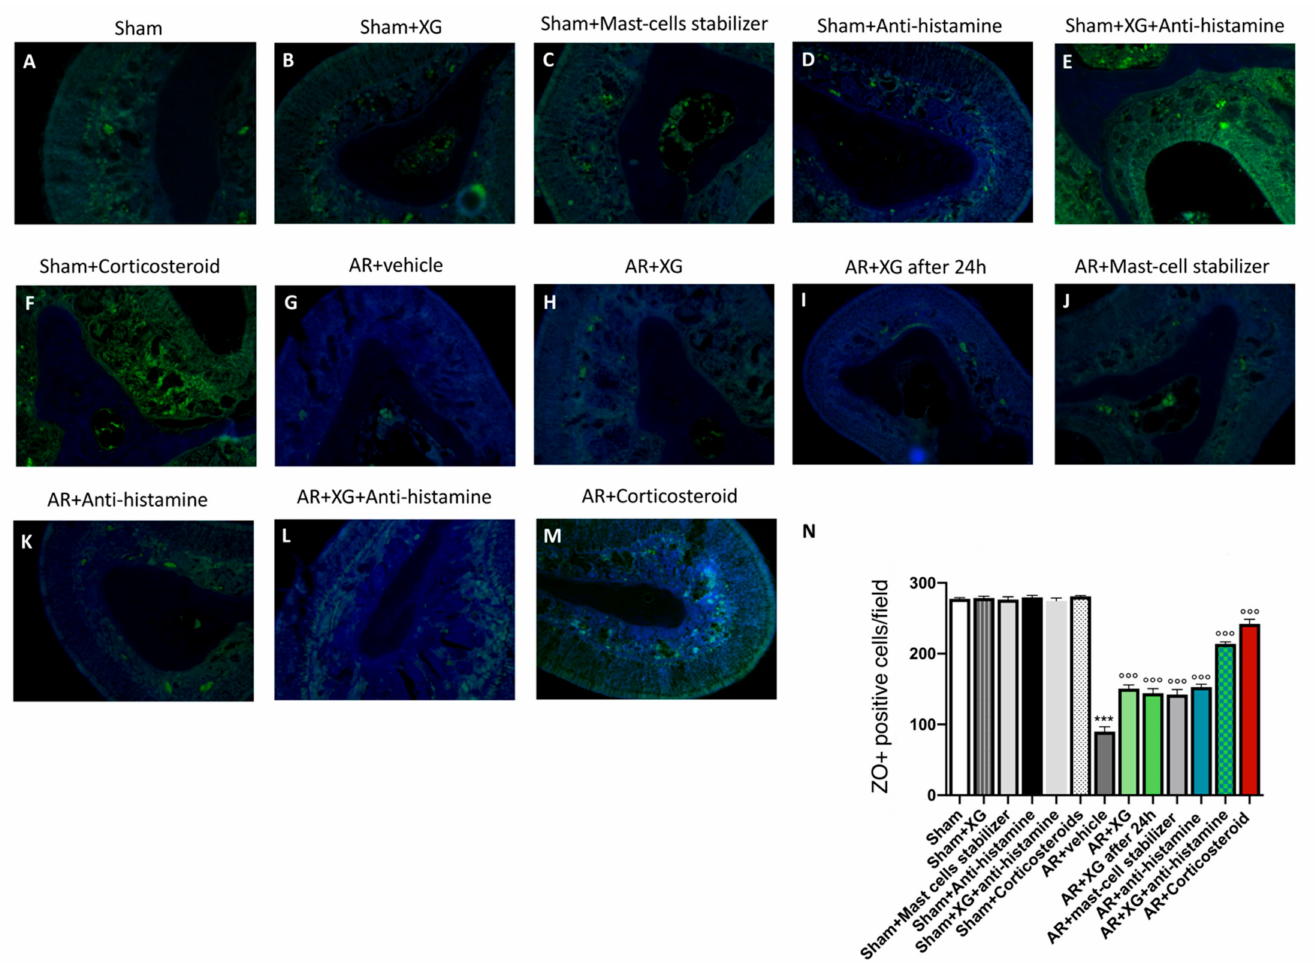
Figure 10. Effect of XG treatment on ZO-1 expression. OVA-challenged nasal mucosa exposed a evident decrease of ZO-1 expression ( G , histological score N ) compared to the sham animals ( A – F , histological score N ); XG-based spray treatment meaningfully preserved ZO-1 expression ( H , I , histological score N ) as well antihistamine ( K , histological score N ) and mast cell stabilizer ( J , histological score N ) treatments. A quantitatively more substantial effect was obtained from the co-administration of XG and antihistamine ( L , histological score N ) as well as corticosteroid administration ( M , histological score N ). Data are representative of at least three independent experiments. Values are means ± SEM. One-Way ANOVA test. *** p < 0.001 vs. Sham; ◦◦◦ p < 0.001 vs. AR +